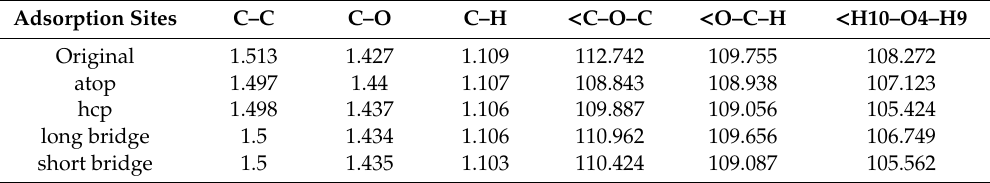
Table 3. Values of bond length (Å) and angle (°) for each state of ether molecule.